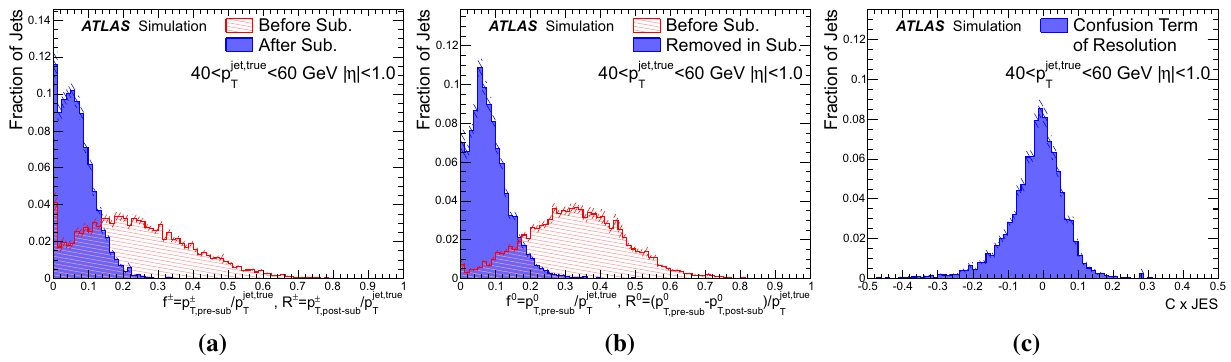
Fig. 20 The fractions of the jet calorimeter energy that have been incorrectly subtracted by the cell subtraction algorithm, for jets with < 60GeV and | η | < 1 . 0 in dijet MC simulation without 40 < p true T pile-up. The statistical uncertainty is indicated by the hatched bands . Subfigure ( a ) shows the fraction of jet transverse momentum carried by reconstructed tracks before subtraction f ± ( hashed ) and the cor-